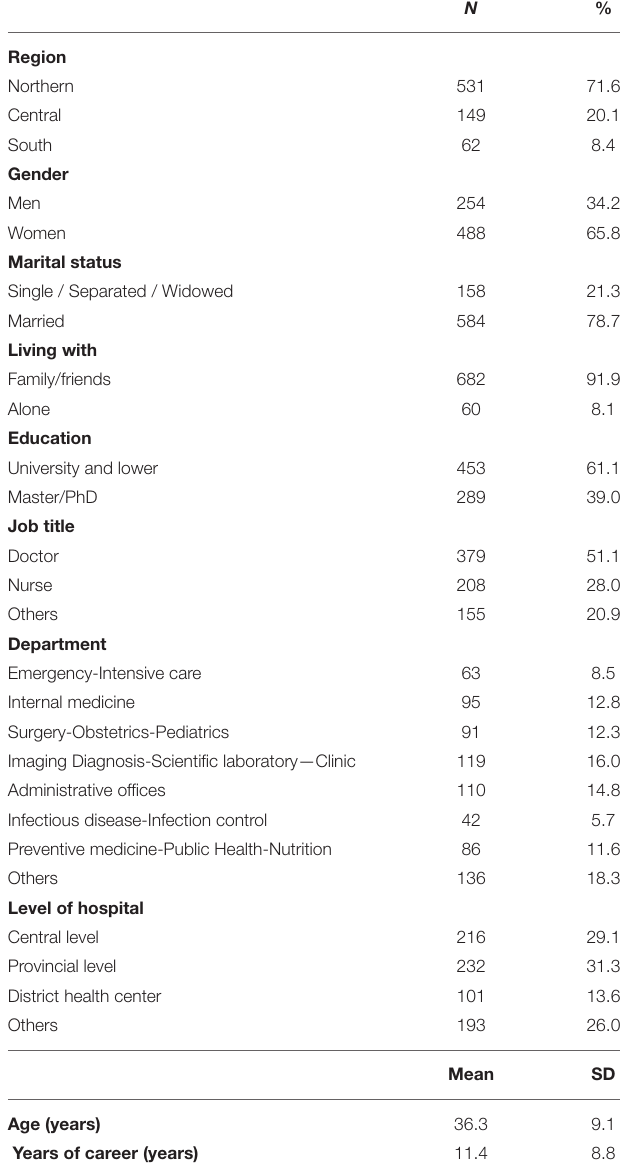
TABLE 1 | Sociodemographic characteristics of